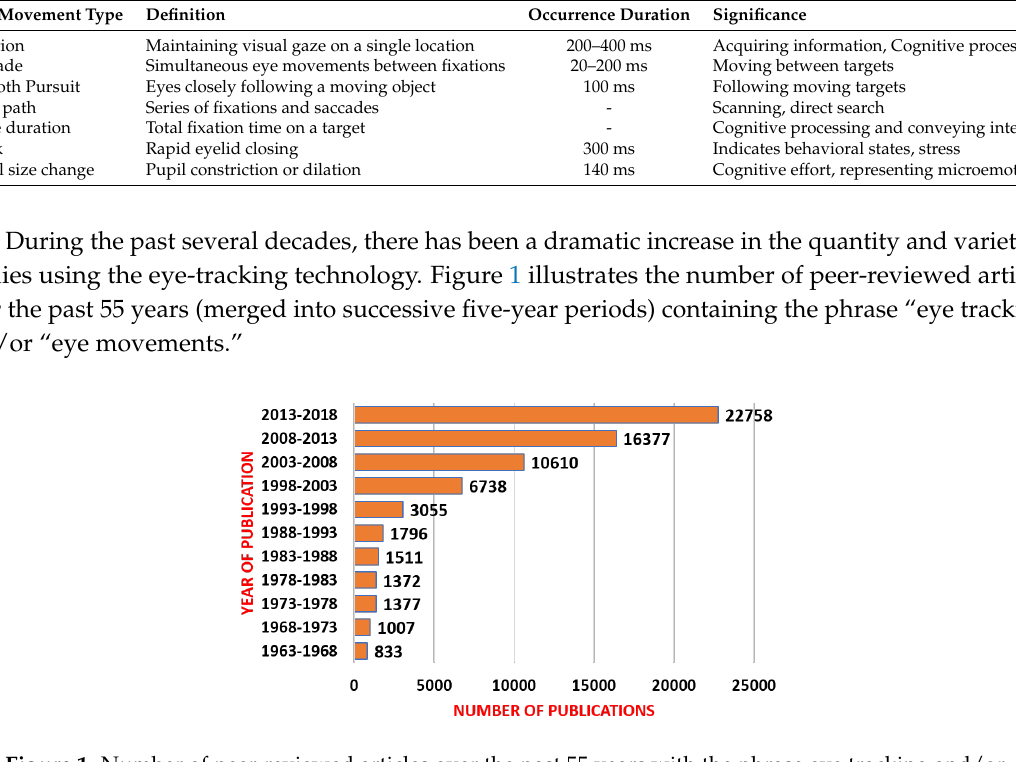
Figure 1. Number of peer-reviewed articles over the past 55 years with the phrase eye tracking and/or eye movements (ProQuest